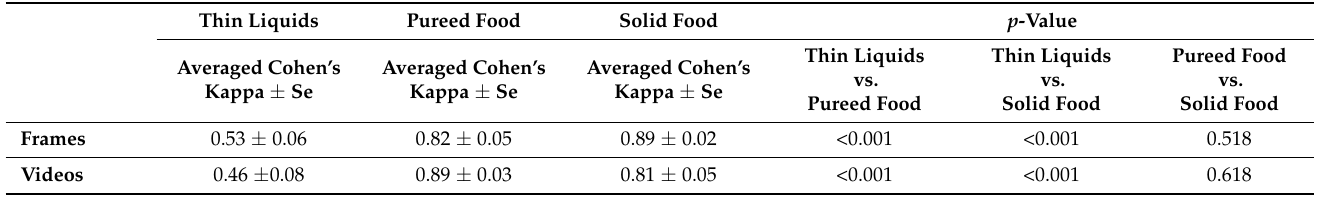
Table 10. Influence of bolus consistency on intra-rater reliability in frames and videos ratings across raters who assessed material twice (n = 15).